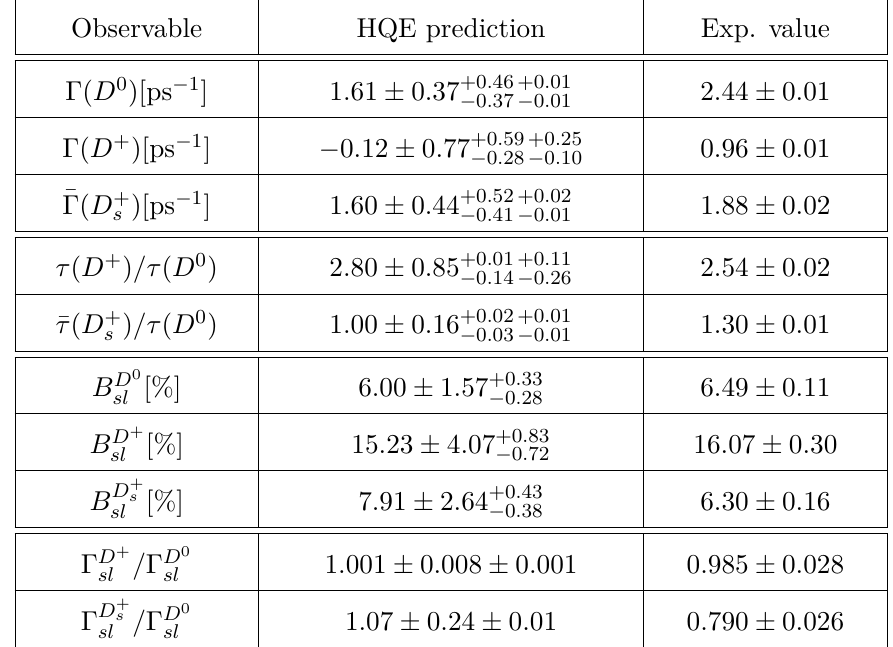
Table 15 . HQE predictions for all the ten observables in the kinetic scheme (second column), using HQET SR results for the Bag parameters. The first uncertainty is parametric, the second and third uncertainties are due to µ - and µ -scales variation, respectively. The results are compared with 1 0 the corresponding experimental measurements (third